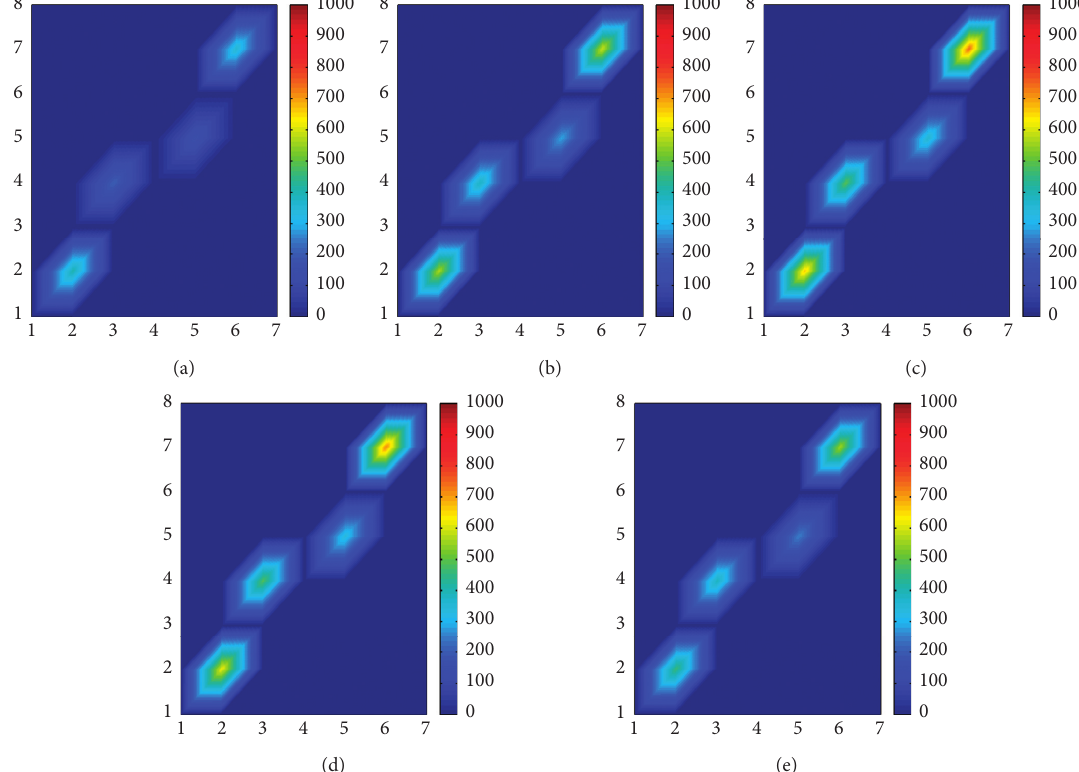
Figure 5: The biomass of middle predator behavior within Ω without the control. (a) t � 0. (b) t � 50. (c) t � 100. (d) t � 150. (e) t �